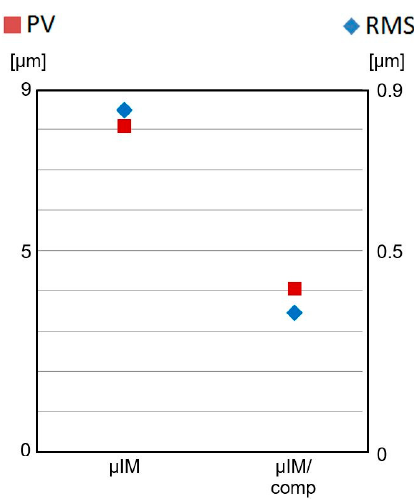
Figure 6. PV and RMS values of the individual optics manufactured. Left: µIM; right: µIM/comp.